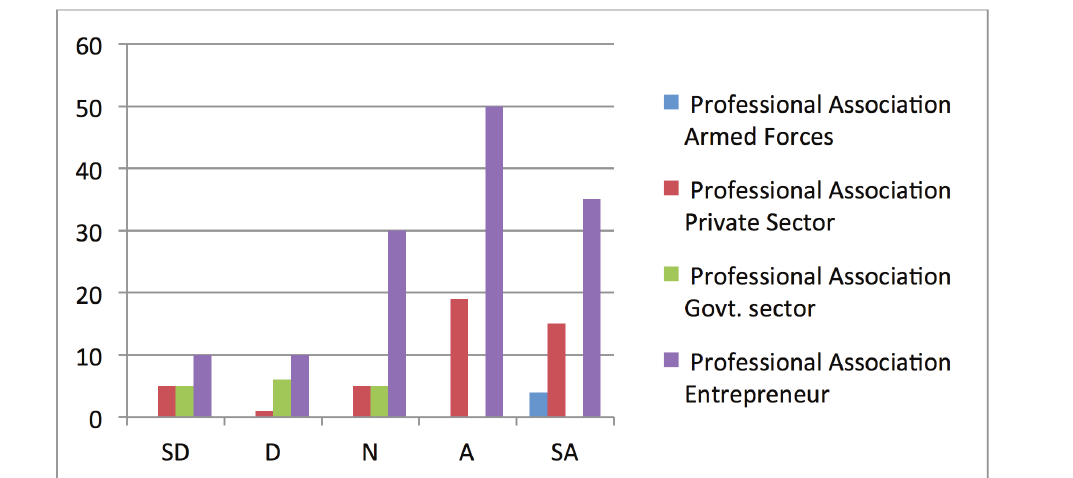
Figure 6: Variable of professional association amongst